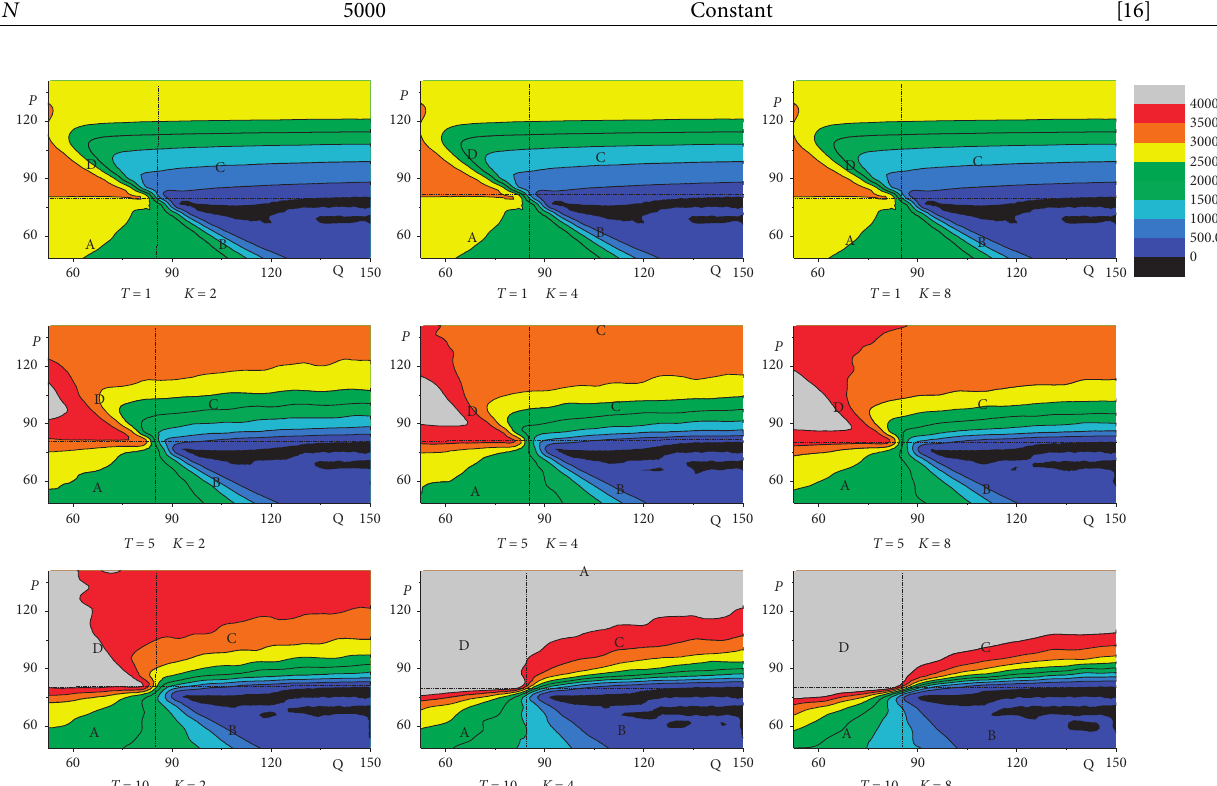
Figure 4: Effectiveness of true decoy strategies in scenarios with different neighbor node